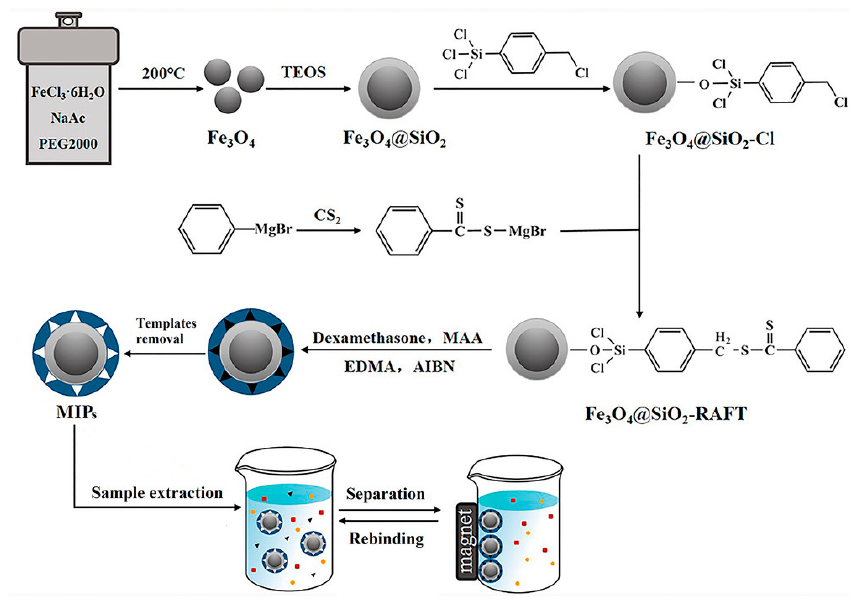
Figure 7. Surface-imprinted magnetic polymers used by Du and coworkers [107] for the extraction and determination of dexamethasone.